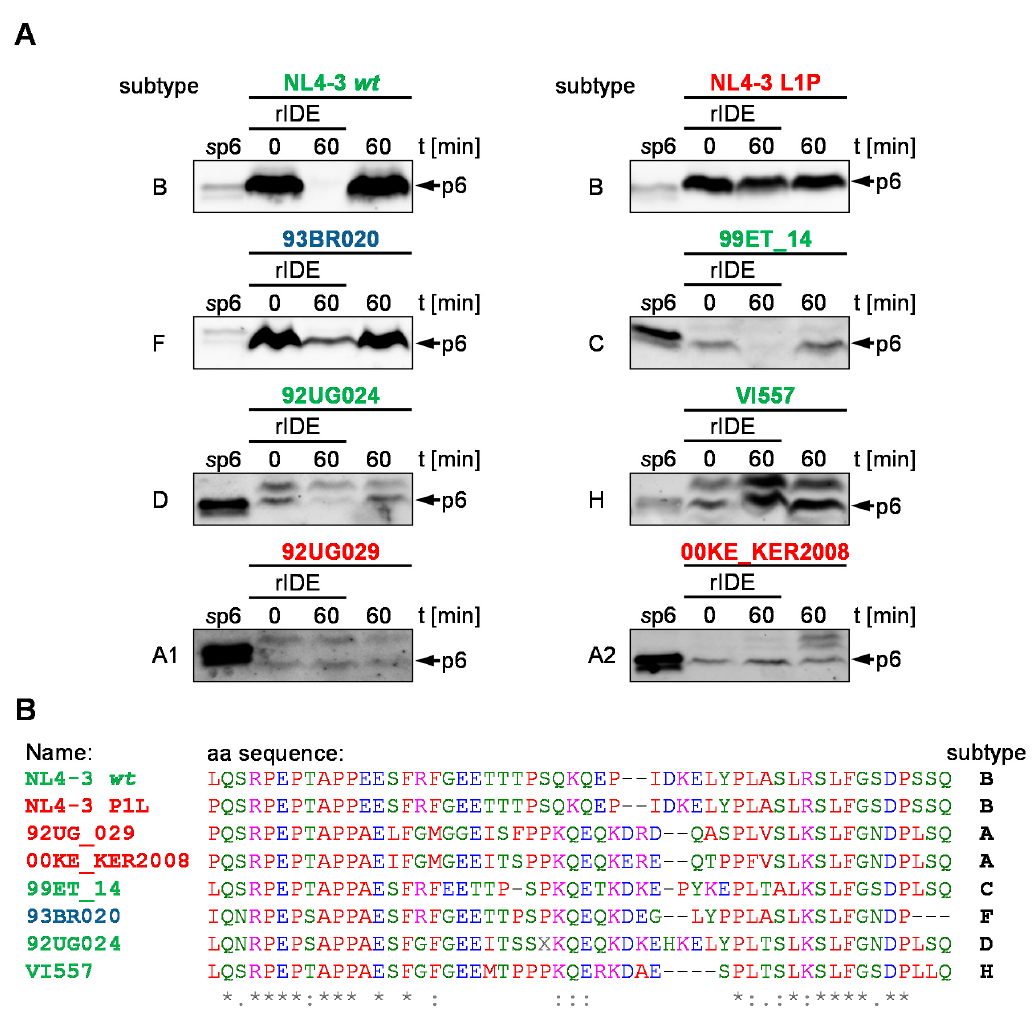
Figure 7. Degradation of p6 derived from various subtypes by IDE. ( A ) rIDE was incubated with v p6 derived from the indicated field isolates. Reactions were stopped by heat inactivation either immediately or after incubation for 60 min at 37 °C. p6 incubated with IDE buffer for 60 min at 37 °C served as negative control. Representative Western blots of four independent experiments are shown. ( B ) Sequence alignment of the isolates tested for sensitivity towards IDE-mediated degradation. Colors of the sequence alignments according to the physicochemical properties of the aa, as proposed by the Clustal Omega multiple sequence alignment software. Conserved aa positions in the sequence alignment are indicated by asterisks. Furthermore, aa exchanges between strongly (colon) and weakly (dot) similar aa residues are specified [45–47].